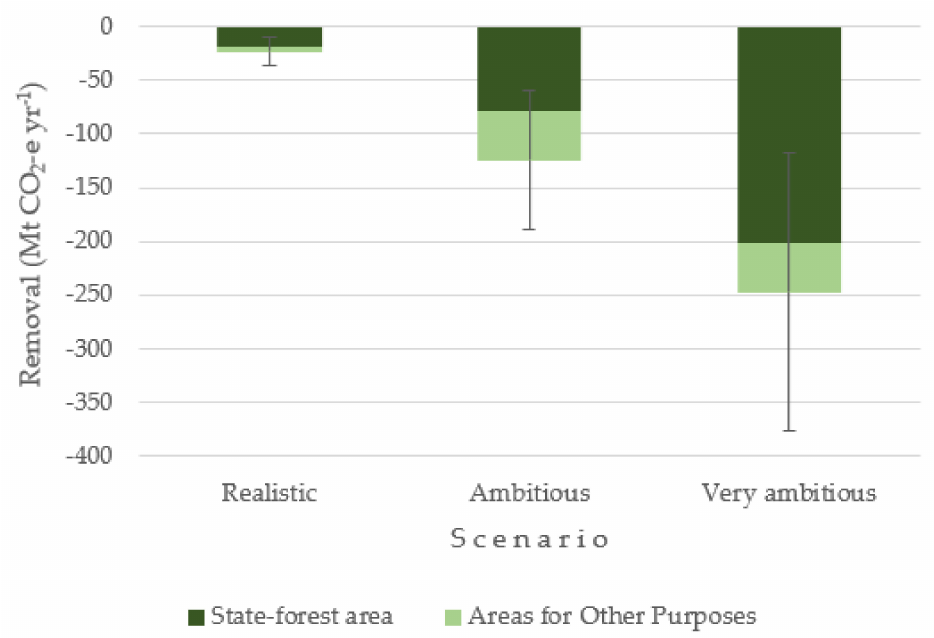
Figure 3. Mean annual carbon sequestration potential of reforestation in 2019–2030 with realistic, ambitious, and very ambitious scenarios. Error bars show ± standard error (SE) of the